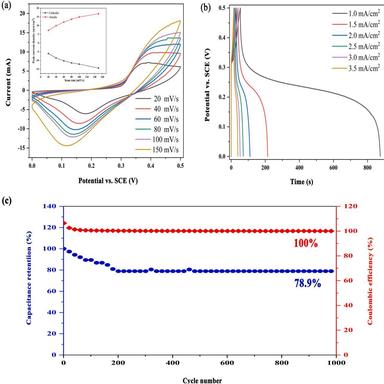
Electrochemical performance of CdSe (40 min) electrode in three-electrode system (a) CV curves at different scan rates (The inset shows the linear curves of peak anode and cathode current as a function of scan rate), (b) GCD curves at different current densities, and (c) cycling stability and coulombic efficiency for 1000 cycles at the current density of 3 mA/cm2 .